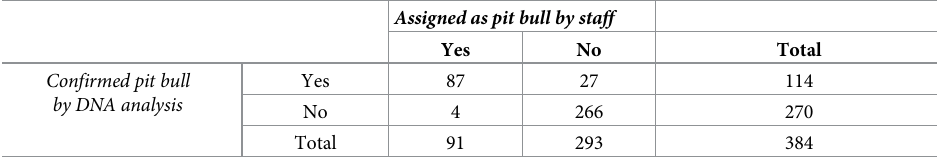
Table 7. Confusion matrix for pit bull-type dog identification comparing dogs assigned a pit bull-type breed by staff and confirmation by DNA analysis for dogs with pit bull-type heritage of 25% or greater. Assigned as pit bull by